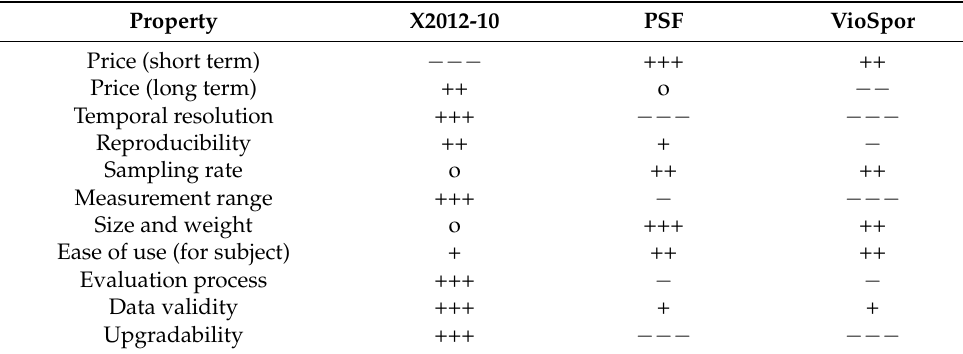
Table 3. Assessment of different properties for the three dosimeter types (electronic, PSF, biological), ranging from very good (+++) to neutral (o) to very poor ( −−− ). Property X2012-10 PSF VioSpor Price (short term) −−− +++ ++ Price (long term) ++ o −− Temporal resolution +++ −−− −−− Reproducibility ++ + − Sampling rate o ++ ++ Measurement range +++ − −−− Size and weight o +++ ++ Ease of use (for subject) + ++ ++ Evaluation process +++ − − Data validity +++ + + Upgradability +++ −−−